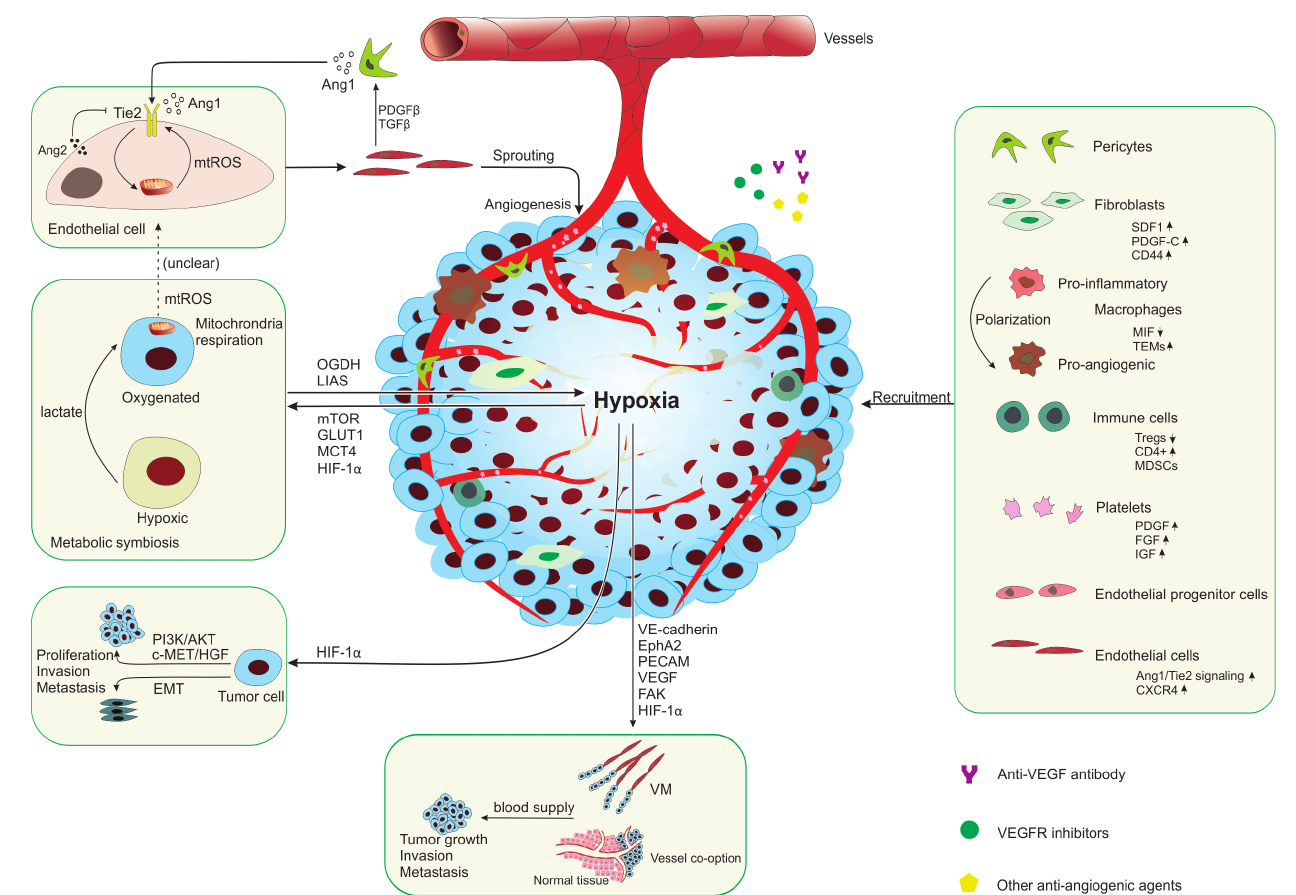
Figure 1. Schematic illustration of the role of the tumor microenvironment in resistance to anti-angiogenic therapy. Anti-angiogenic therapy inhibits tumor growth by reducing vessel density; however, the subsequent hypoxia and the responsive genes can cause resistance to such therapy. The hypoxia-related metabolic symbiosis, invasion and metastasis, vessel co-option, and vasculogenic mimicry (VM) lead to resistance to anti-angiogenic therapy. The recruitment of stromal cells also plays a critical role in resistance to anti-angiogenic therapy. Ang1/2, angiopoietin 1/2; CXCR4, C-X-C chemokine receptor type 4; EMT, epithelial-to-mesenchymal transition; EphA2, Eph receptor A2; FAK, focal adhesion kinase; FGF, fibroblast growth factor; GLUT1, glucose transporter-1; HGF, hepatocyte growth factor; HIF-1 α , hypoxia- inducible factor 1 α ; IGF, insulin-like growth factor; LIAS, lipoic acid synthase; MCT4, monocarboxylate transporter 4; MDSC, myeloid-derived suppressor cell; MIF, macrophage migration inhibitory factor; mTOR, mammalian target of rapamycin; mtROS, mitochondria reactive oxygen species; OGDH, oxoglutarate dehydrogenase; PDGF, platelet-derived growth factor; PECAM, platelet endothelial cell adhesion molecule; SDF1, stromal cell-derived factor 1; TEM; Ties-expressing macrophage; Treg, regulatory T cell; VE-cadherin, vascular endothelial cadherin; VEGF, vascular endothelial growth